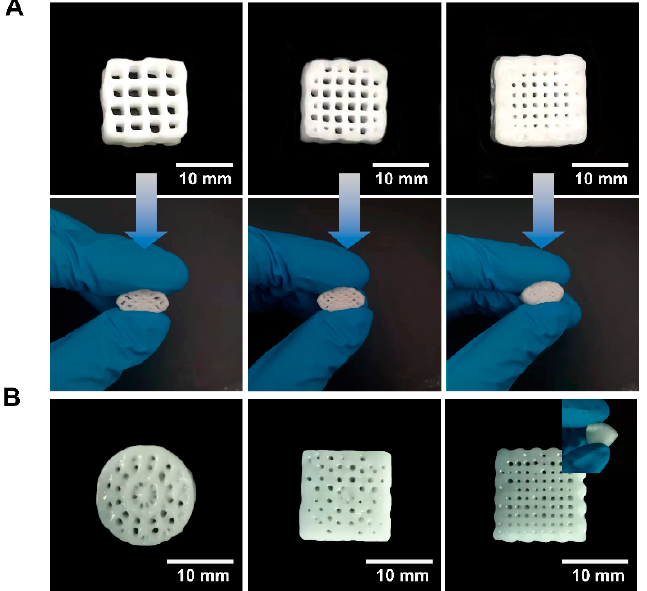
Figure 9. ( A ) Photos of compression test samples. ( B ) The printing bioreactors with other infill pat- terns.